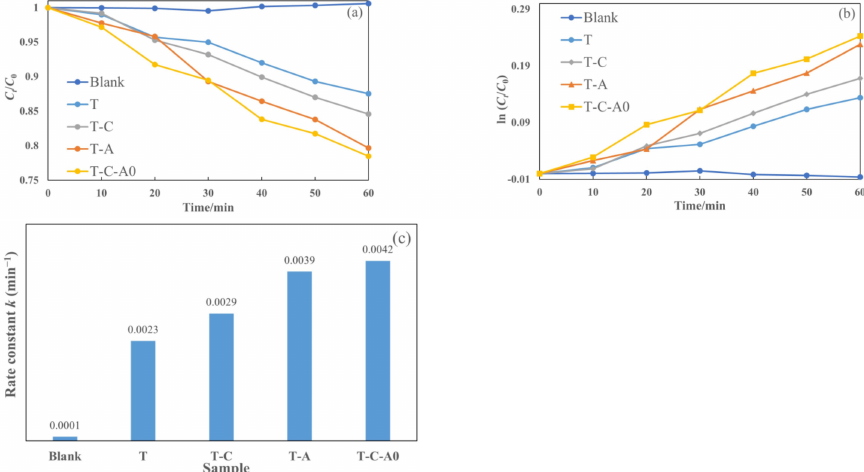
Figure 9. Photocatalytic activity for the degradation of rhodamine 6G by different films under simulated solar light: ( a ) degradation with respect to time, ( b ) ln ( C t / C 0 ) versus to time plot and ( c ) rate constants degradation for various